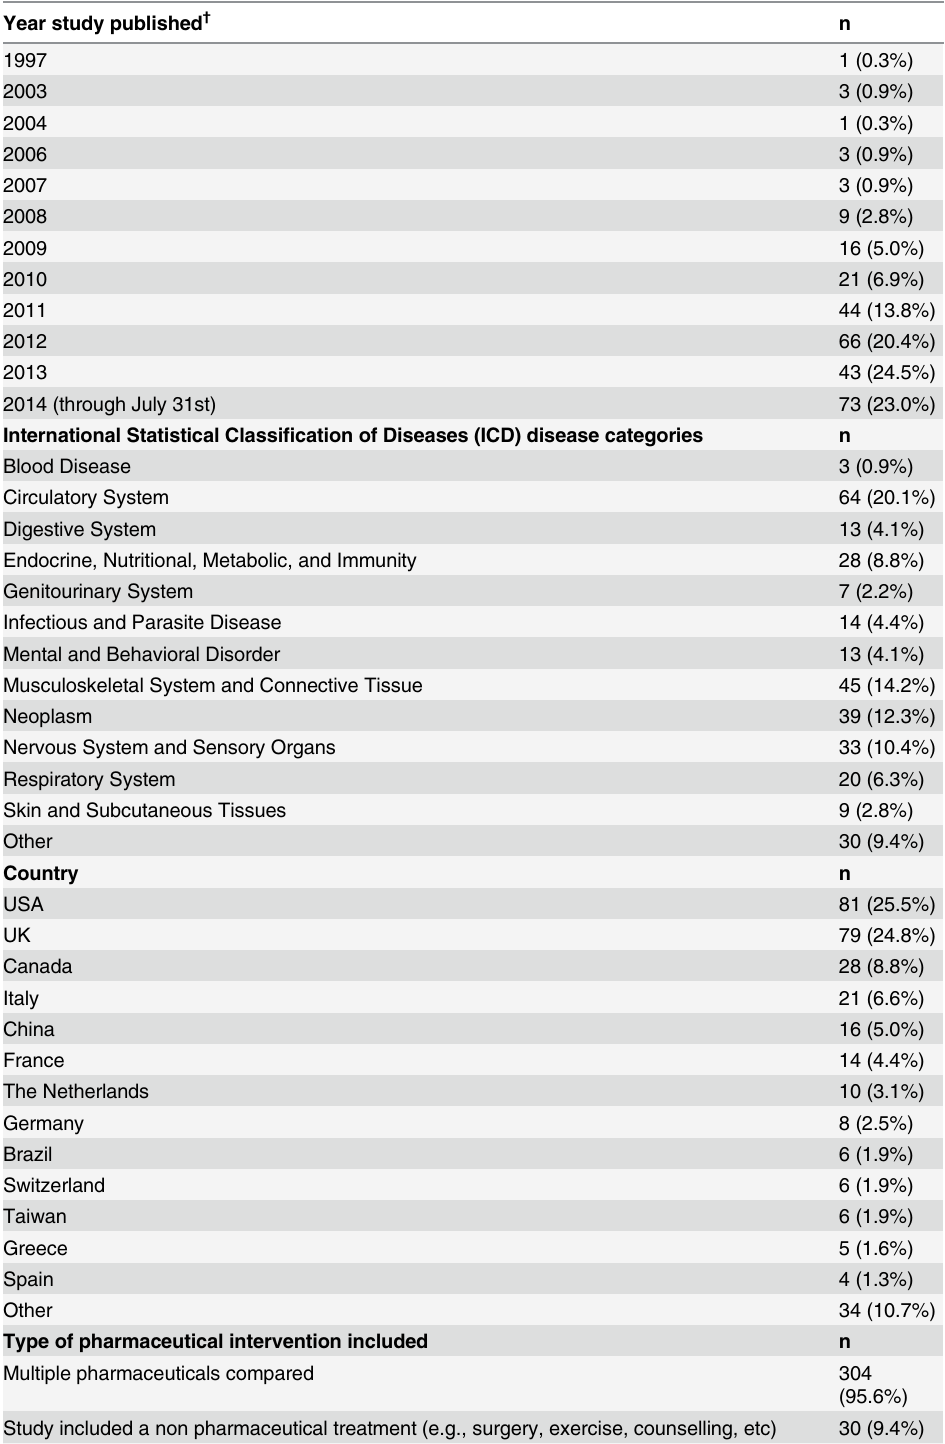
Table 1. Frequency of network meta-analyses (n = 210) by year, indication, and